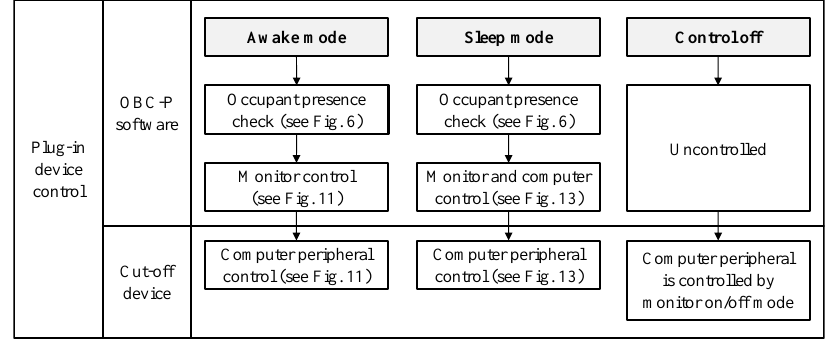
Figure 1. Role of OBC-P software and cutoff device for plug-in device control.